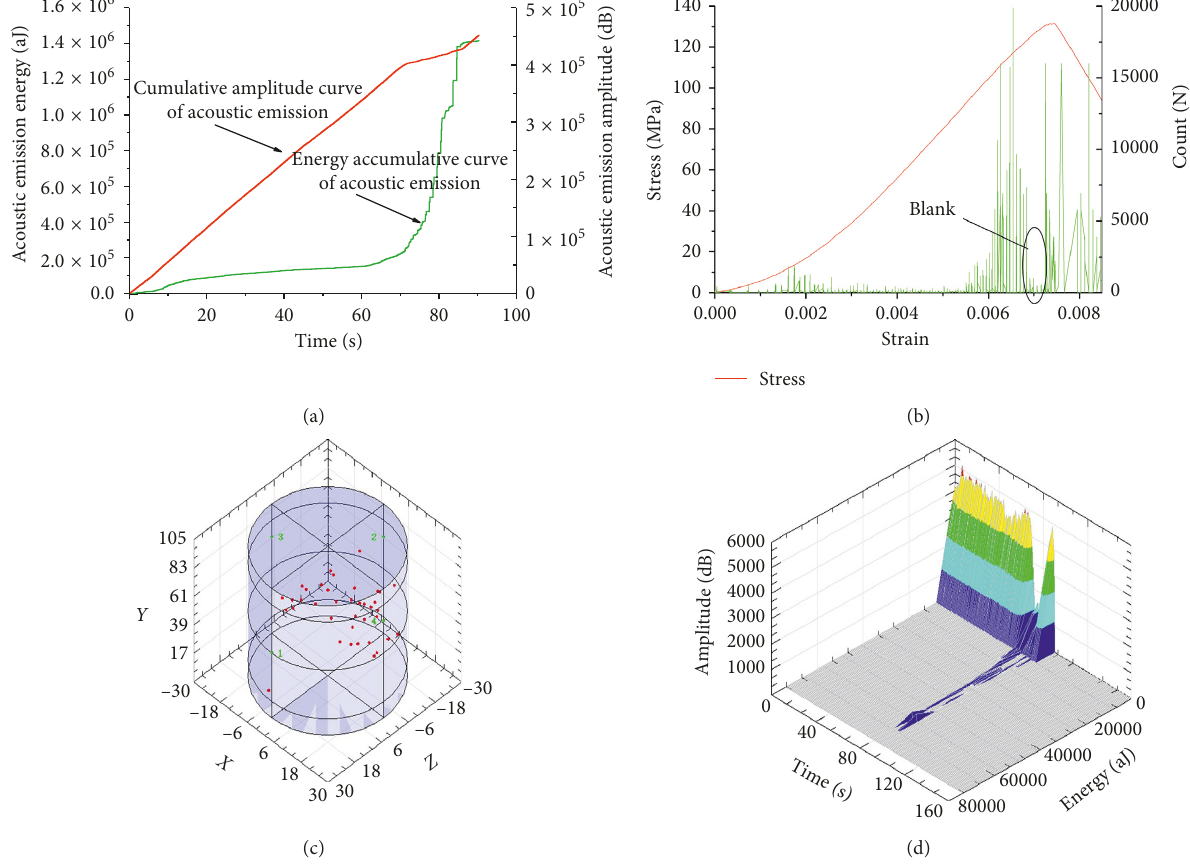
Figure 10: AE characteristics of basalt columnar joints of dry state under uniaxial compression: (a) AE amplitude and AE energy time, (b) AE count and time, (c) AE location, and (d) AE amplitude, energy, and time.